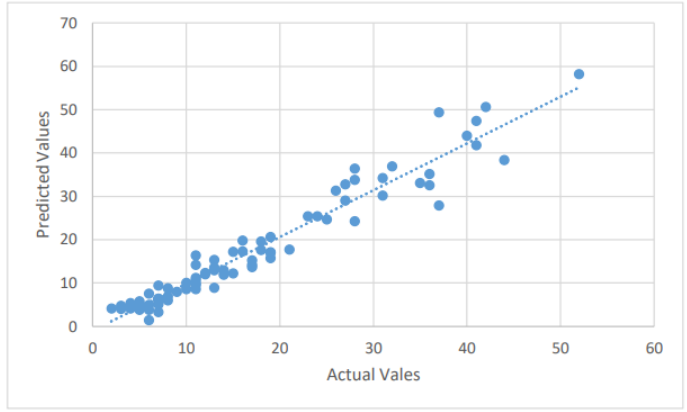
Figure 4. A scatter plot of the mortality cases by the LSTM on the testing dataset.